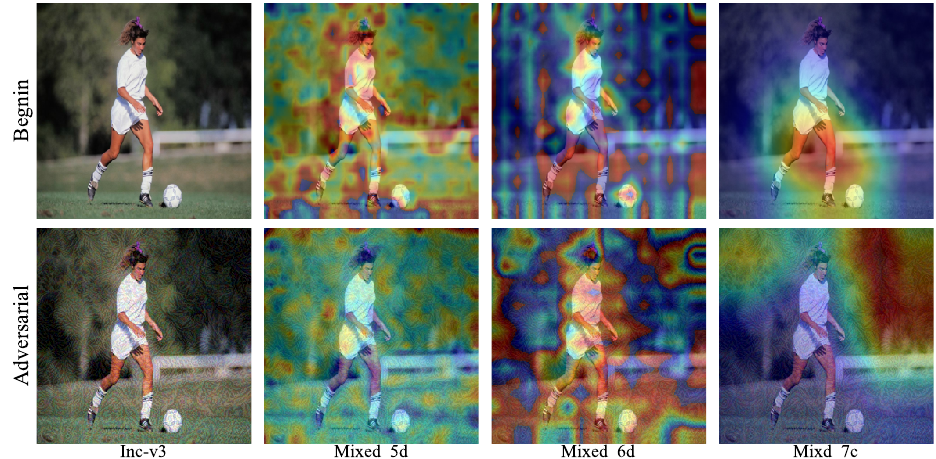
Figure 2. Visualisation of the features of adversarial and benign examples on different layers on the Inception-V3 model. The features are visualised by Grad-Cam